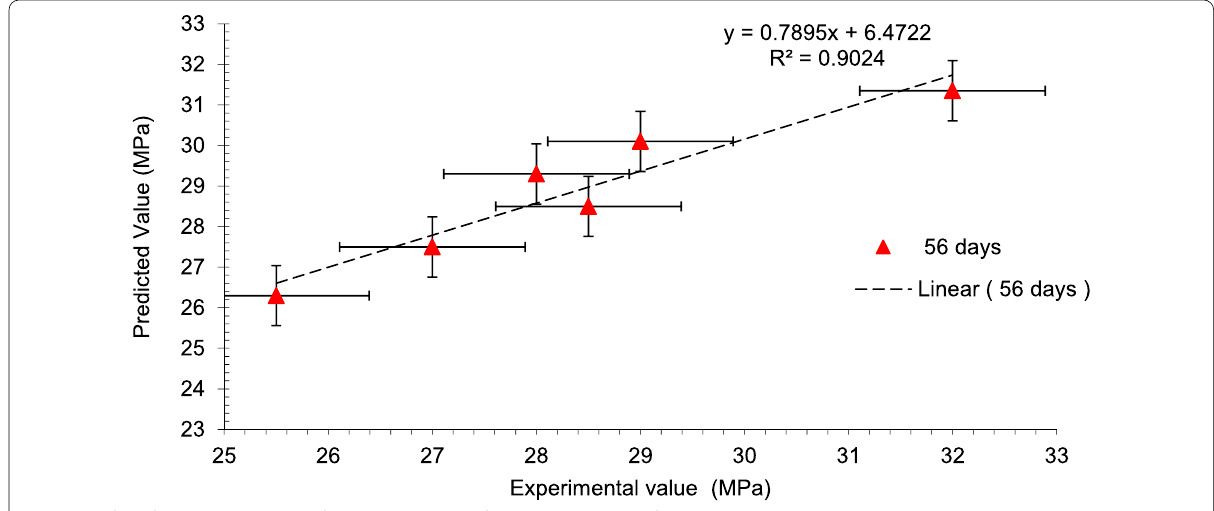
Fig. 9 Predicted compressive strength verse experimental compressive